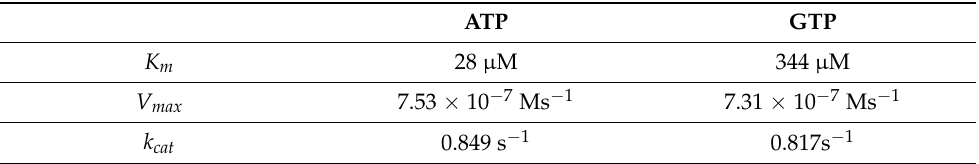
Table 3. Kinetic parameters for the hydrolysis of NTP by